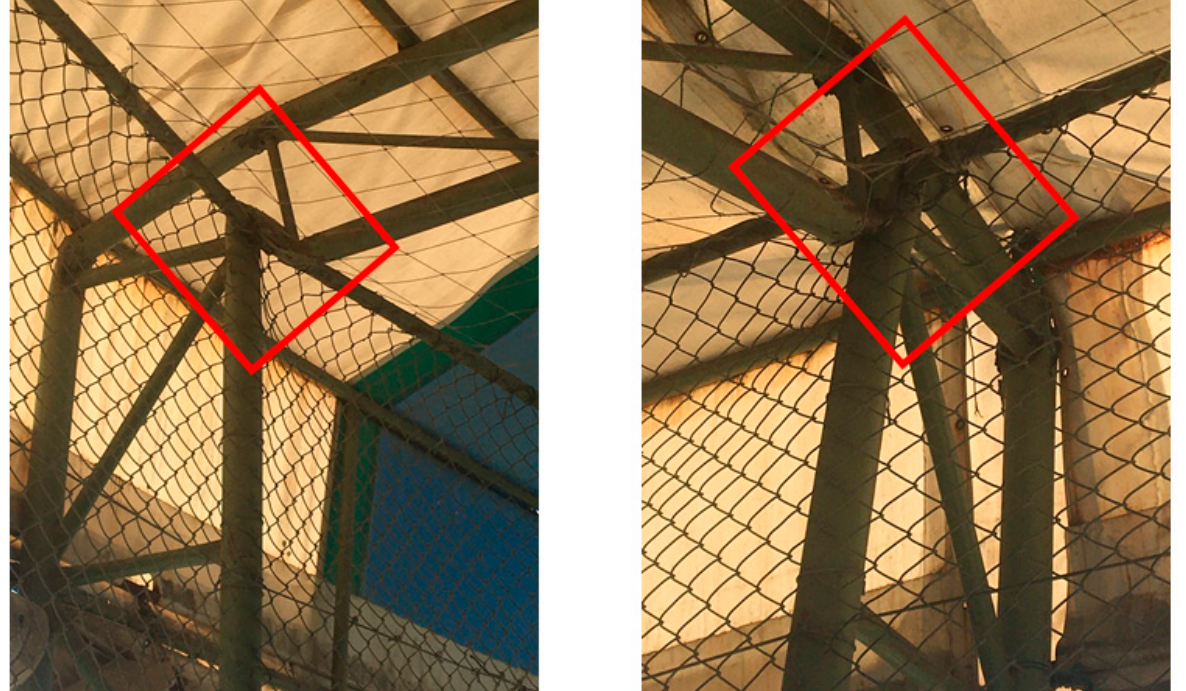
Figure 12. Observed damage at the end of rafter system in Model 4.